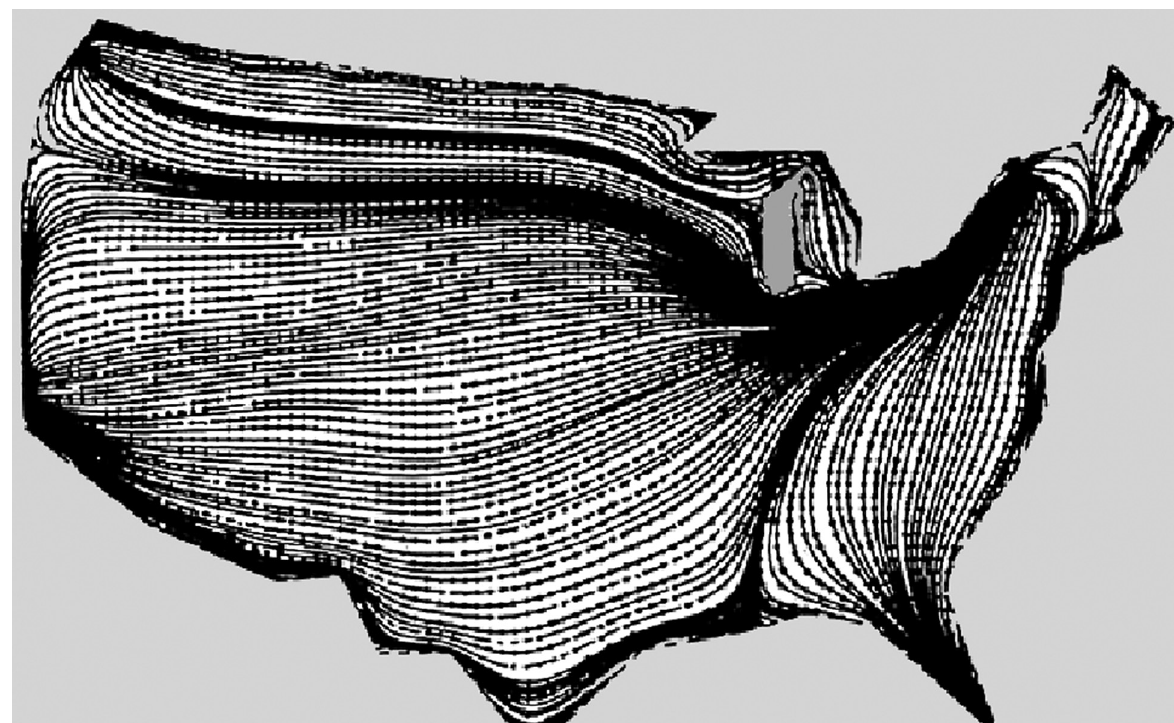
domainsFig. 6. Same, shown as pressure contours and migration